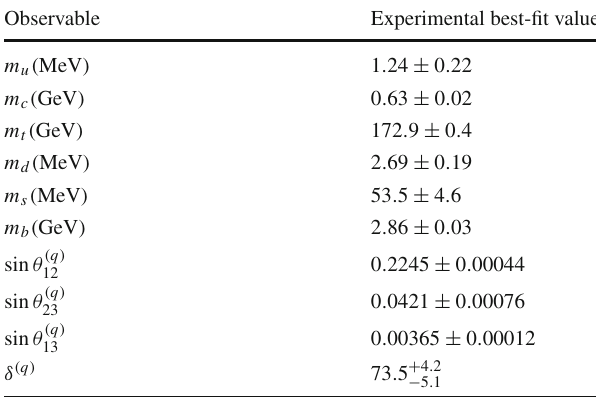
Table 4 The best-fit results for quark masses and mixings taken from [76] and [53,75], respectively. Note that the experimental values of the quark masses are given at the M Z scale